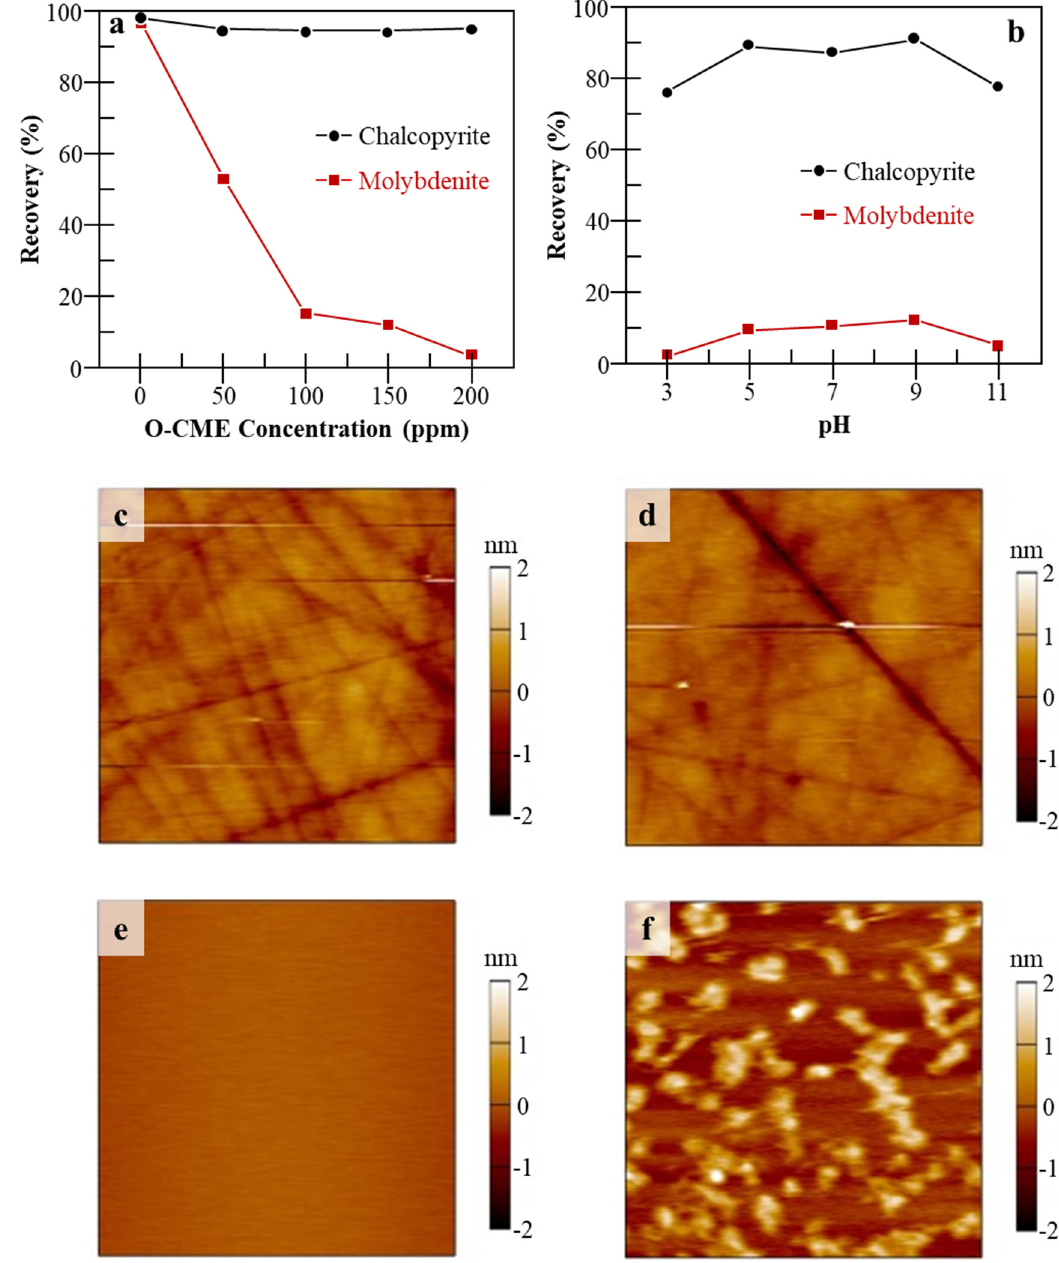
Figure 5. Effect of O-CMC on selective depression of molybdenite: ( a ) single-mineral flotation in 1 mM KCl solution with 20 ppm KIBX at pH 9 under various concentrations of O-CMC; ( b ) flotation of artificially mixed minerals (chalycopyrite:molybdenite = 1:1 by weight) in 1 mM KCl solution with 20 ppm KIBX and150 ppm O-CMC as function of pH, and atomic-force-microscopy (AFM) height profiles of ( c ) bare chalcopyrite, ( d ) chalcopyrite treated with 150 ppm O-CMC, ( e ) bare molybdenite, and ( f ) molybdenite treated with 150 ppm O-CMC (reprinted with permission from Yuan et al. [32], copyright (2019) Elsevier).